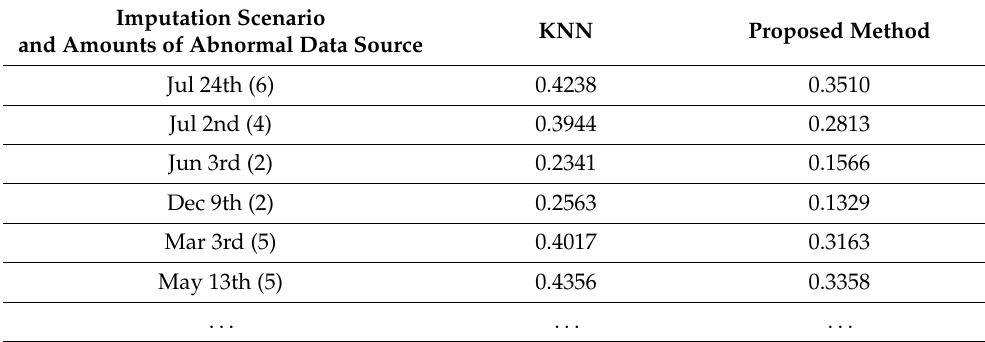
Table 6. Average filling errors of the proposed method and KNN algorithm in partial filling